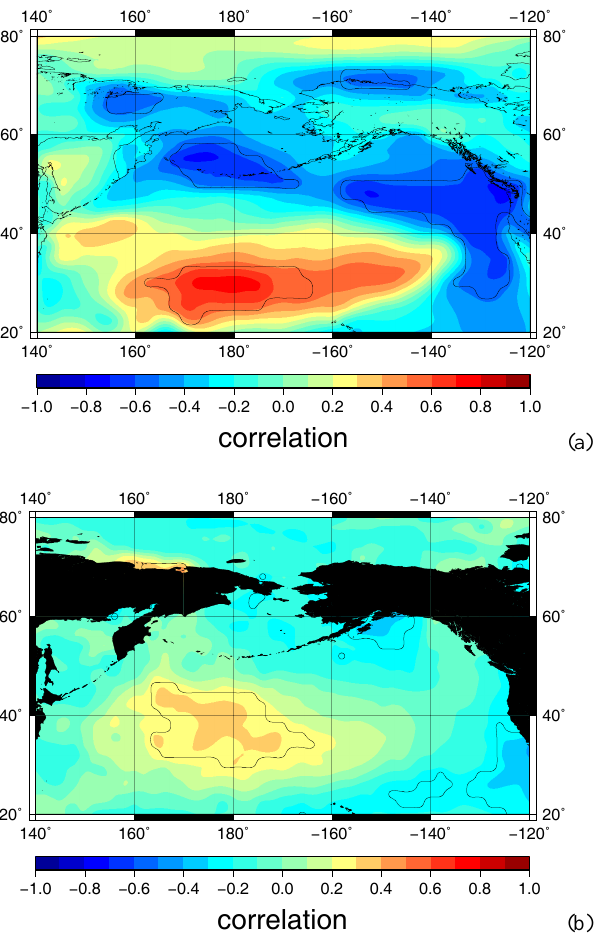
Fig. 9. (a) Correlation map of the ice core δ D with ERA-40 3yr mean surface (2m) temperature for 1958–1996 (39yr). Black con- tours indicate the land-water margin and the 90% confidence level. b) Correlation map of the ice core δ D with ERSST 3yr mean sea surface temperature for 1854–1995 (142yr). Black contours indi- cate the land-water margin and the 90% confidence level.